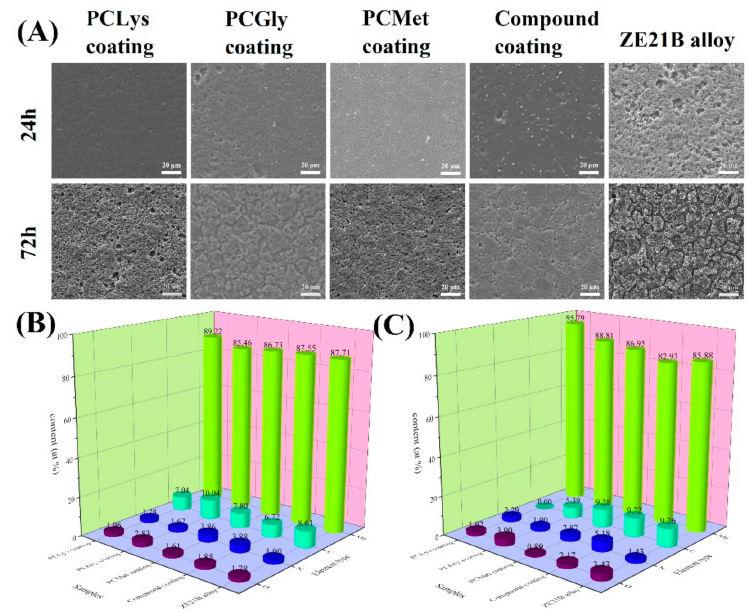
Figure 5. ( A ) SEM images of each sample without corrosion products after being immersed in the RPMI 1640 cell culture medium for 24 h and 72 h; EDS results of each sample with corrosion products after immersed in the RPMI 1640 cell culture medium for ( B ) 24 h and ( C ) 72 h.